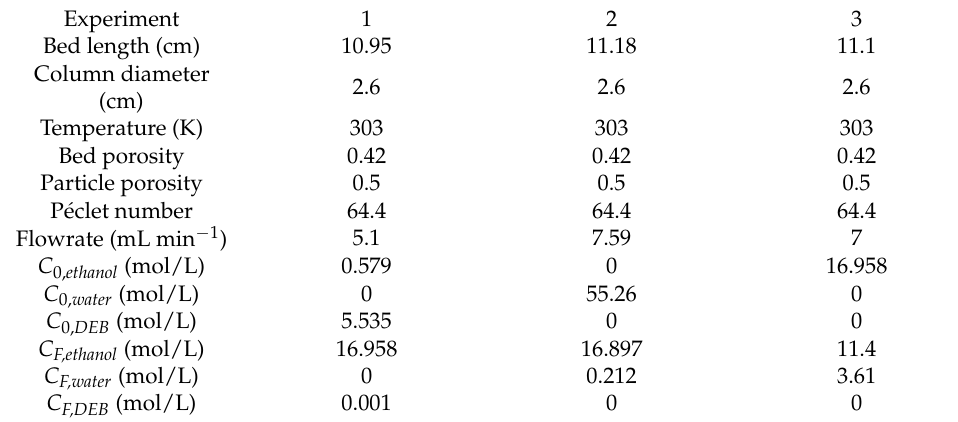
Table 2. Experimental conditions used for the fixed bed